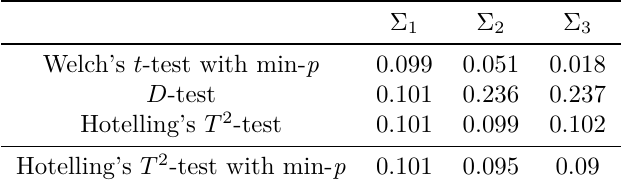
Table 1: Empirical false positive rate ˆ α estimated from 100 , 000